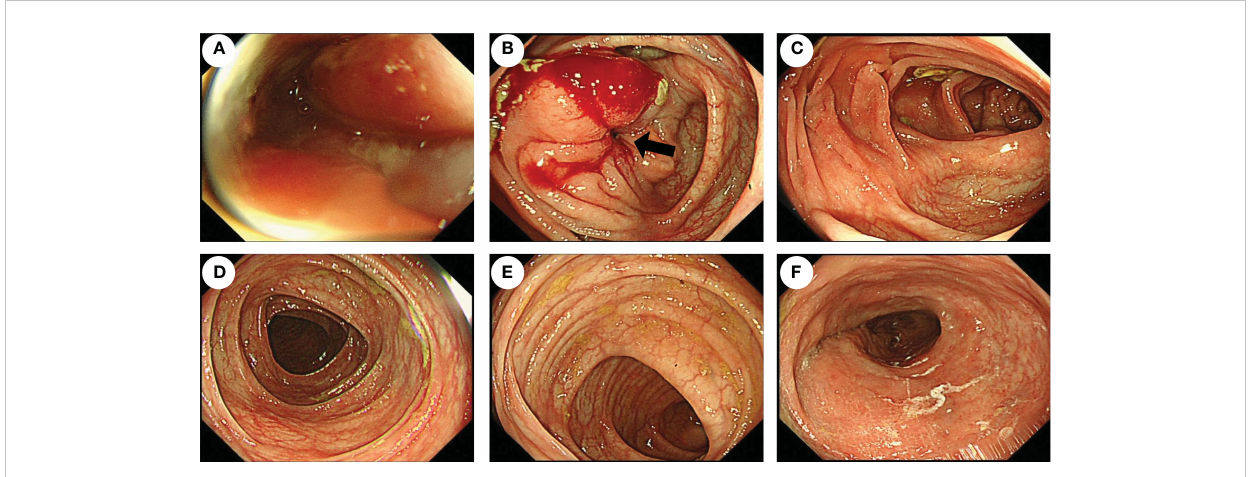
FIGURE 2 Endoscopic features of the patient before surgery. Colonoscopy showed that the cavity was obviously narrow in the ileocecal region (black arrow), which made the endoscope unable to pass through (A, B) , but there were no obvious abnormalities in the ascending colon (C) , transverse colon (D) , descending colon (E) , or rectum (F)